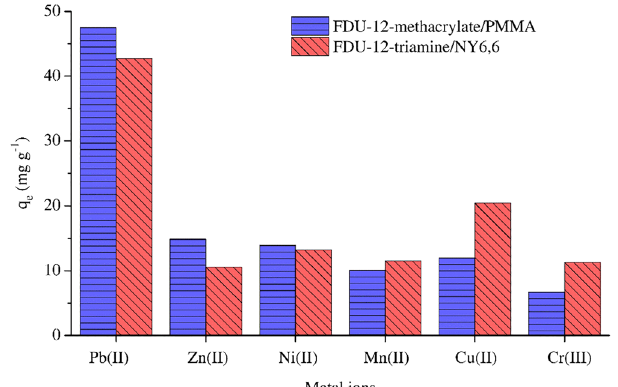
Figure 9. Selectivity of FDU-12-methacrylate/PMMA and FDU-12-triamine/NY6,6 in the presence of coexisting metal